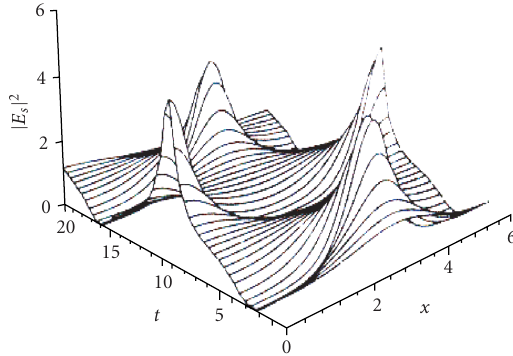
Figure 3.2. Solution to the theoretical model (2.16)–(2.19). The initial conditions are A = 1, α = 1 . 2, β = c = 0 . 1, V = 0, and ϕ =